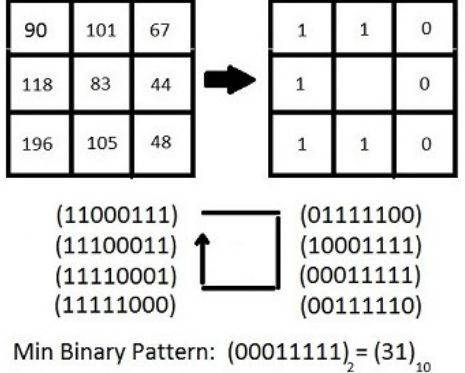
Figure 3. Illustration of RILBP value generation for a 3 × 3 gray image window, where M = 8 and Radius = 1. The binary pattern is rotated clockwise